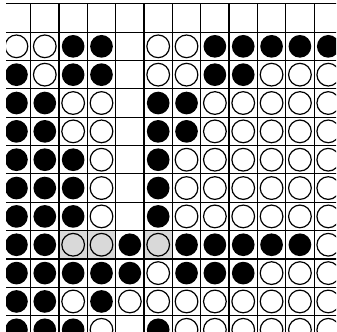
Figure 58. BLACK captures.